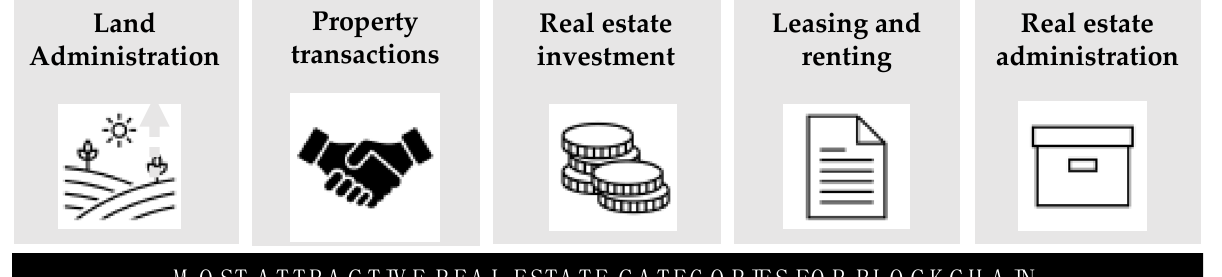
Figure 6 (cid:48) s upper left side compiles the main blockchain pros in the real estate sector. Gen-